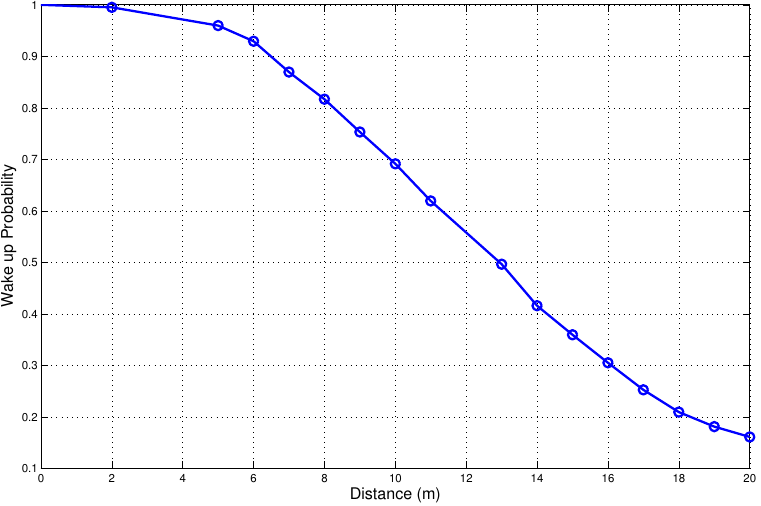
Figure 7. Wake up probability vs.